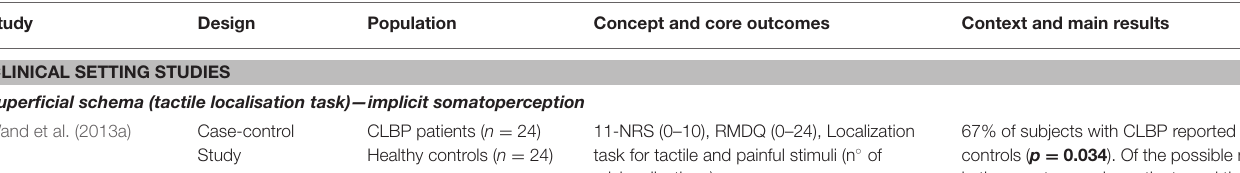
TABLE 3 | Synopsis of included assessment